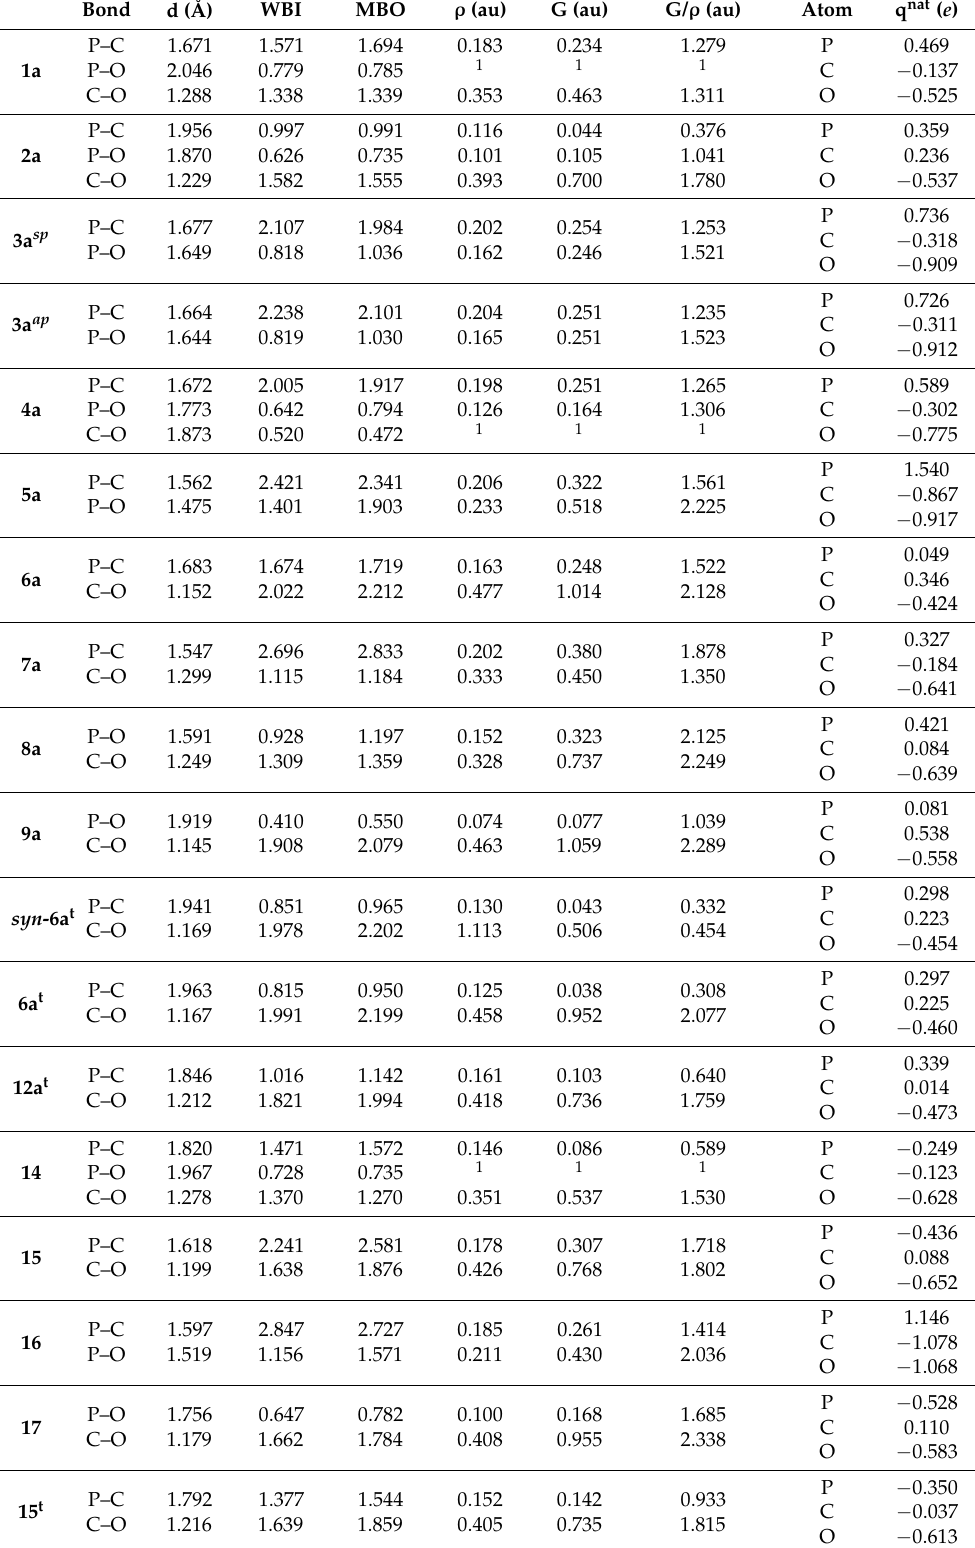
Table 1. Endocyclic bond strength parameters and natural